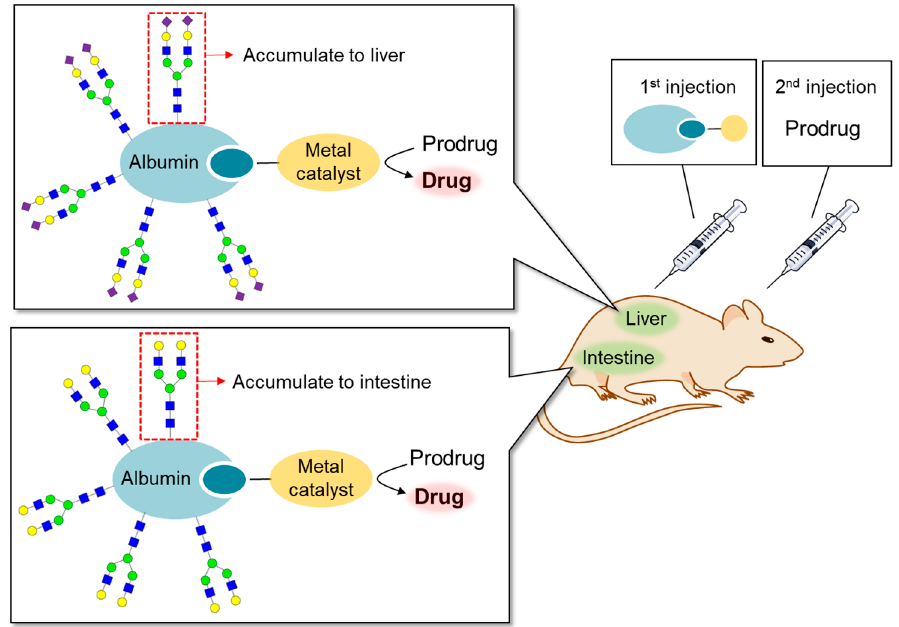
Figure 9. In vivo reaction using artificial glycosylated albumin metalloenzymes. Specific N -glycan conjugated albumin is specifically uptaken into the specific organs. Thus, the albumins conjugated with N -glycans were used as carriers of metal catalysts to realize chemical reactions for the activation of prodrug at the desired organ.